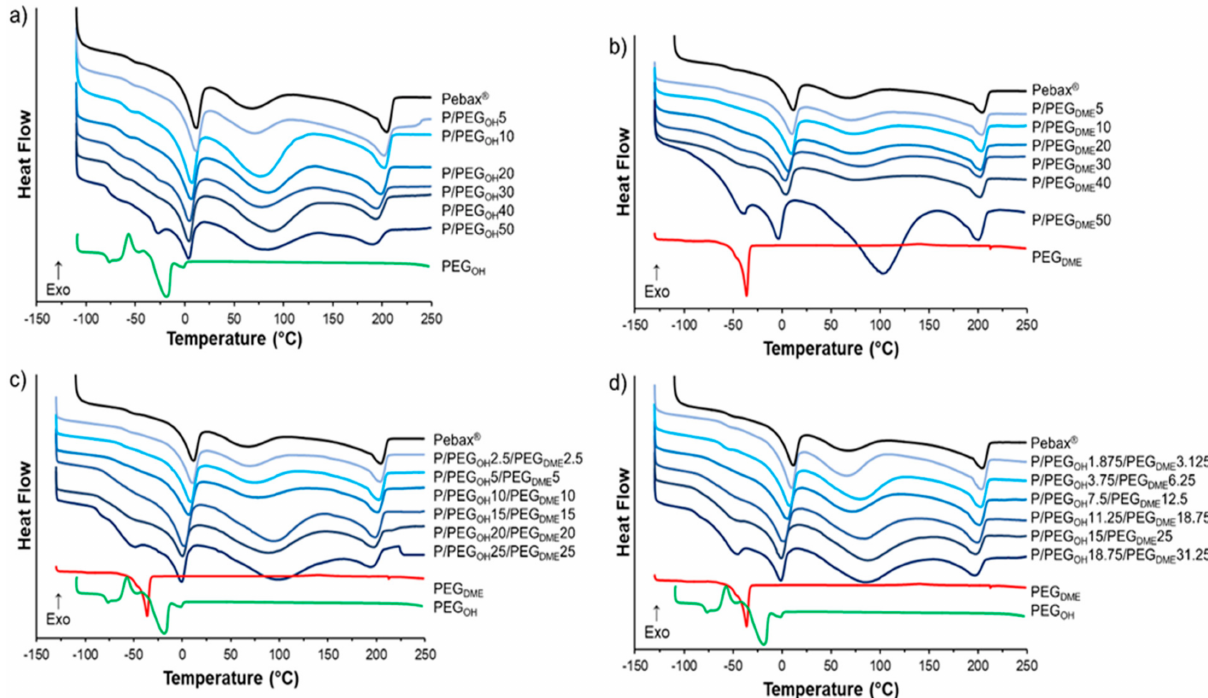
Figure 2. DSC thermograms of the pristine Pebax ® , PEG additives, and Pebax ® /PEG OH blends ( a ), Pebax ® /PEG DME blends ( b ), Pebax ® /PEG OH /PEG DME blends with a 50/50 PEG OH /PEG DME weight ratio ( c ), and Pebax ® /PEG OH /PEG DME blends with a 37.5/62.5 PEG OH /PEG DME weight ratio ( d